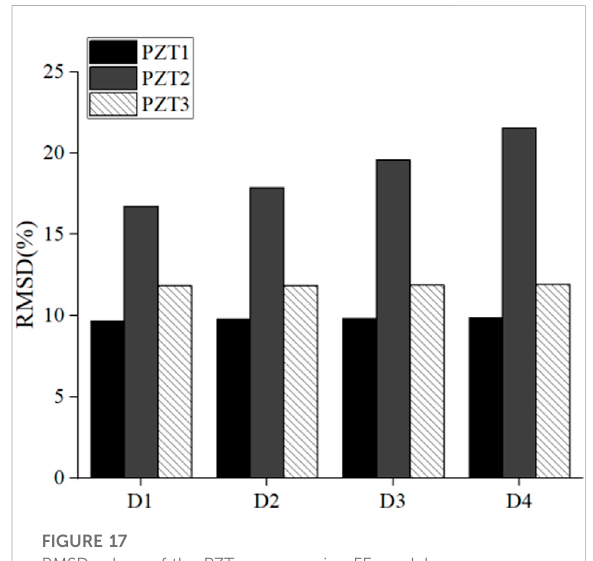
FIGURE 17 RMSD values of the PZT sensors using FE